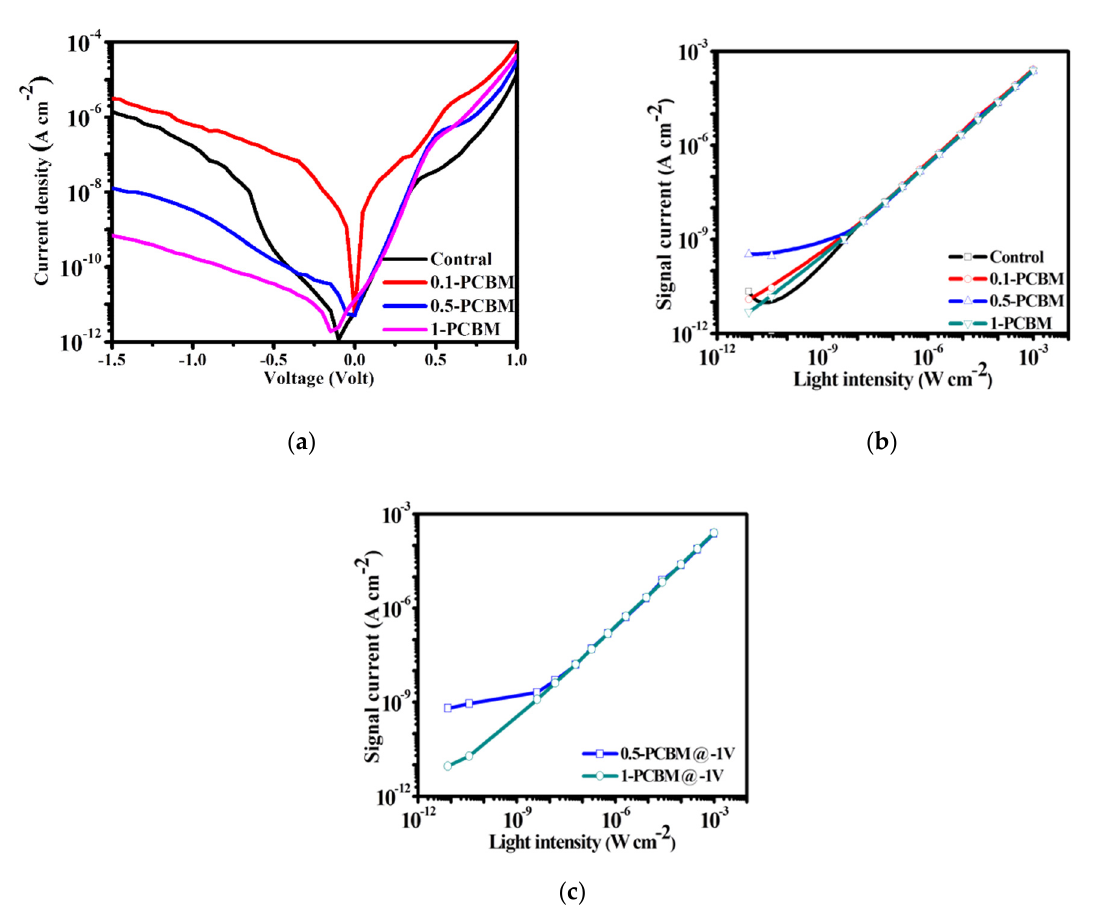
Figure 2. ( a ) Dark current curves of the OPDs. ( b ) LDRs of the OPDs under zero bias. ( c ) LDRs of 0.5–PCBM and 1–PCBM at − 1 V.